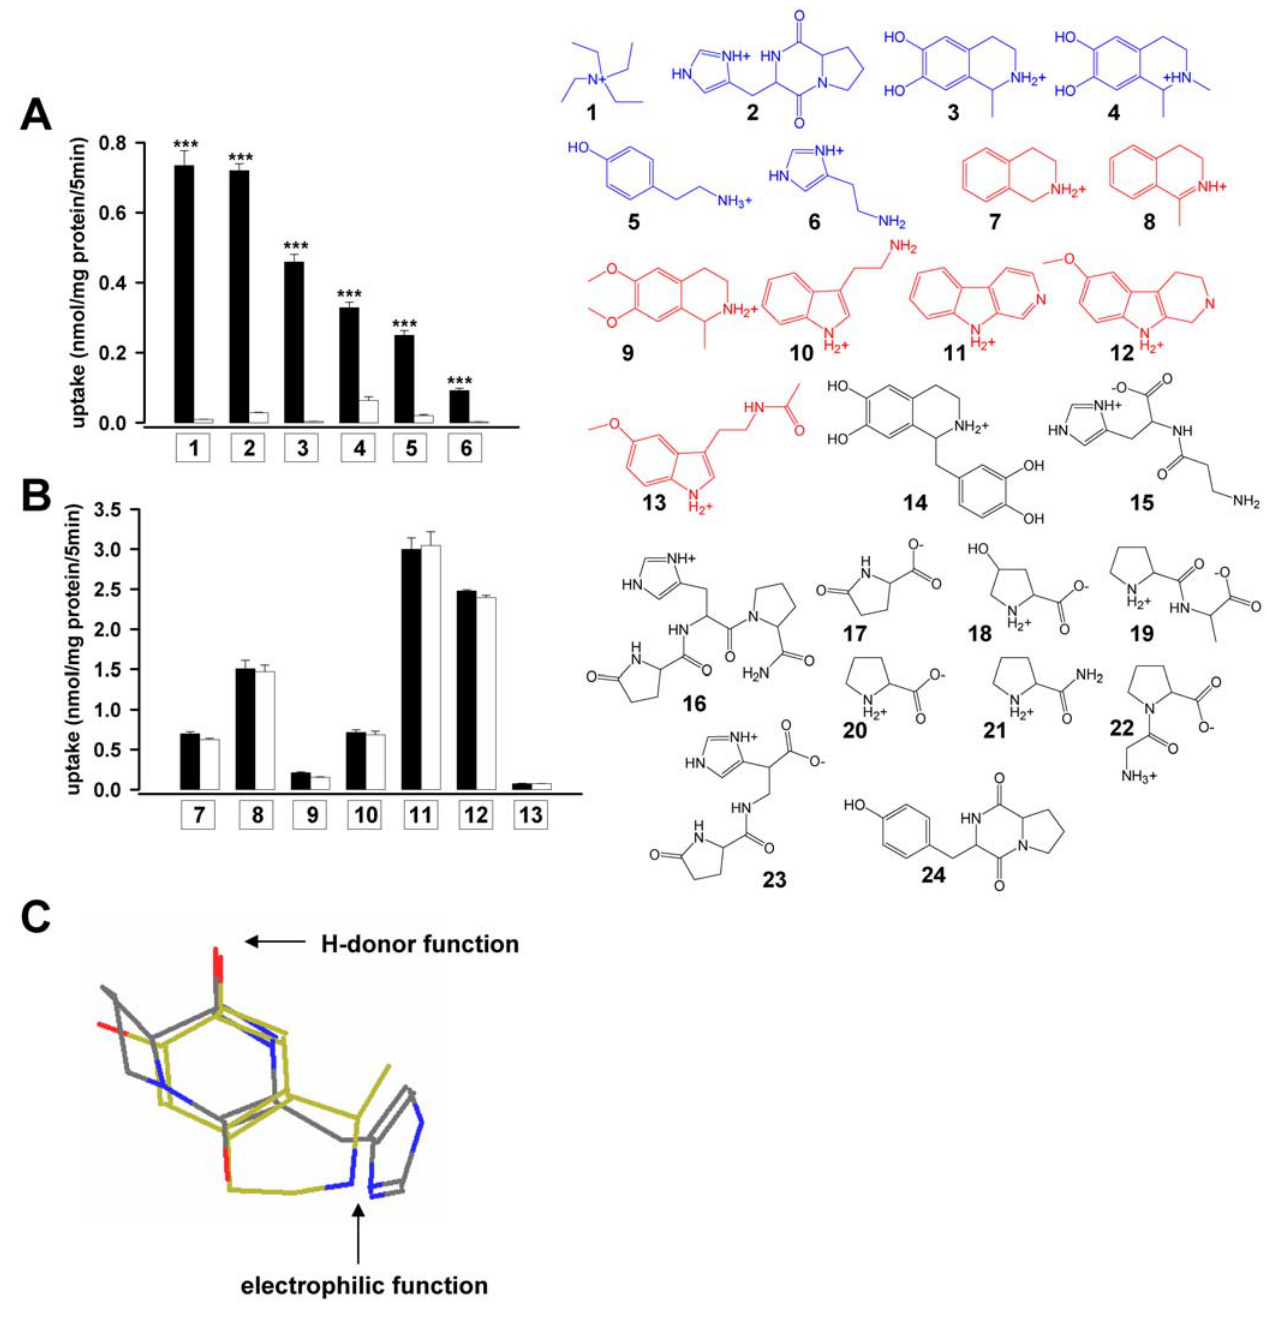
Figure 2. Selectivity of cyclo(his-pro) and salsolinol as endogenous substrates of the organic cation transporter OCT2. (A and B) Accumulation of selected compounds in HEK-293 cells expressing OCT2 (black bars) compared to cells expressing empty vector (open bars) after 5 min of incubation with 10 m mol/l each (n=3, mean 6 s.e.m.; ***P , 0.001). Substances showing significantly higher accumulation in OCT2 than in control cells (specific OCT2-mediated transport) are depicted in blue; substances with equal accumulation in OCT2 and control cells (unspecific OCT2-independent transport) are shown in red, and substances without detectable uptake in OCT2 or control cells are shown in black. (1: tertaethylammonium; 2: cyclo(his-pro); 3: salsolinol; 4: N-methyl-salsolinol; 5: tyramine; 6: histamine; 7: 1,2,3,4-tetrahydroisoquinoline; 8: 1-methyl-3,4-dihydroisoquinoline; 9: salsolidine; 10: tryptamine; 11: norharmane; 12: 6-methoxy-1,2,3,4-tetrahydro- b -carboline; 13: melatonin; 14: tetrahydropapaveroline; 15: carnosine; 16: thyrotropin-releasing hormone (TRH); 17: pyroglutamate; 18: 4-hydroxy-proline; 19: prolylalanine; 20: proline; 21: prolineamide; 22: glycylproline; 23: pyroglutamyl-histidine; 24: cyclo(tyr-pro)). (C) The overlay of energy minimized conformations (MM2 computation, Chem3D Pro software) of native cylo(L-his-L-pro) (enol tautomer, endo-conformation)[24] and R-salsolinol uncovers close structural similarities, suggesting a planar ring system, an electrophilic center, and a nucleophilic moiety with H-donor properties at a constant distance (of 6.5 6 0.3 A˚) as key properties of a OCT2-specifc substrate.